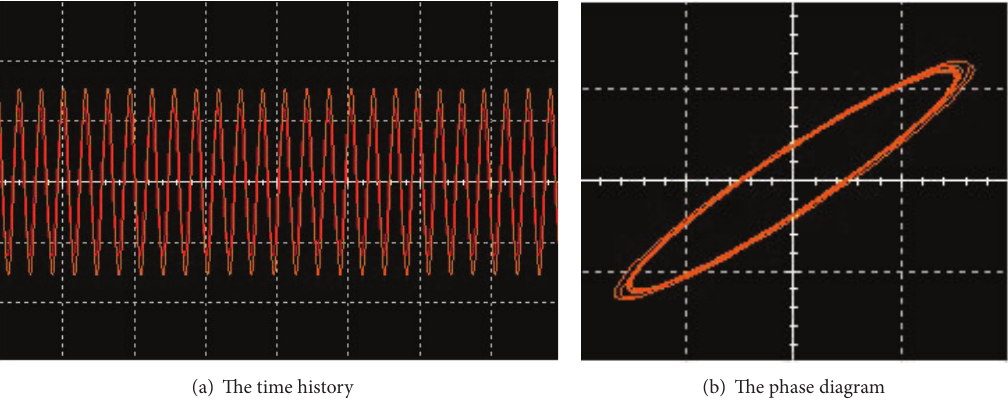
Figure 18: Experimental observations of the time history and phase diagram of system (16) with 𝑎 = 1 , 𝑐 = 0.08 , 𝑚 = 0.5 , 𝑘 1 = 0.8 , 𝑘 2 = 0.5 , and 𝑏 = −0.175